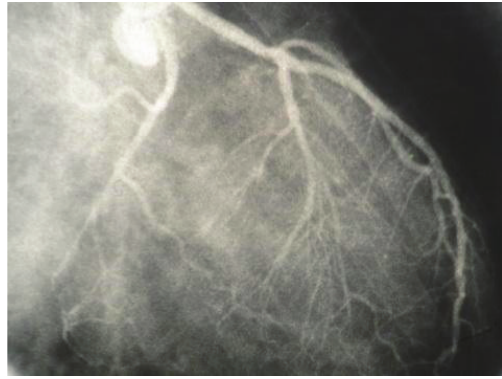
Figure 5: Left coronary artery with minimal narrowing.